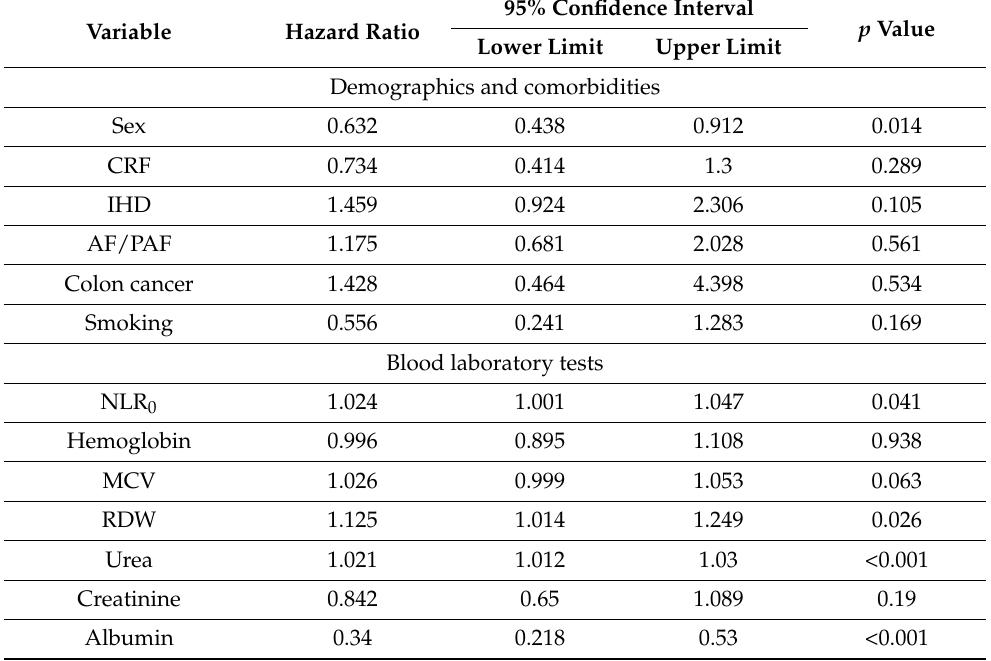
Table 3. A Cox regression analysis: The dependent variable is a death (yes or no) during the first year following a surgery for a proximal femur fracture in the elderly population. The covariables have been detected as having a statistically significant association with the dependent variable on a preliminary univariate analysis. CRF, chronic renal failure; IHD, ischemic heart disease; AF, atrial fibrillation; PAF, paroxysmal atrial fibrillation; MCV, mean corpuscle volume; RDW, red blood cell distribution. 95% Confidence Interval p Value Variable Hazard Ratio Lower Limit Upper Limit Demographics and